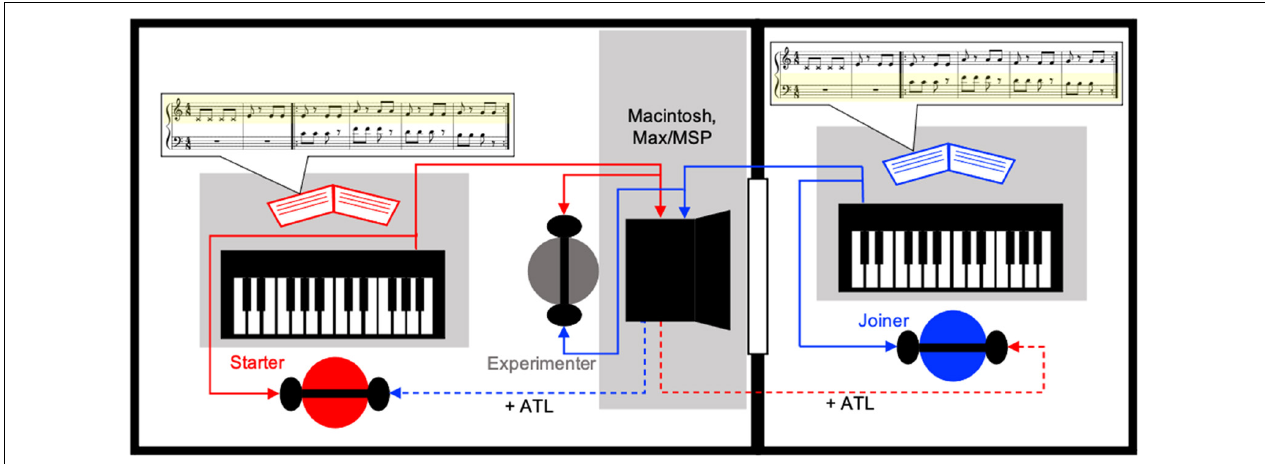
FIGURE 1 | The experimental set-up. The experimenter (center, gray circle) was able to see both pianists (red and blue circles) while they were located in separate rooms and could not see each other. The keyboards were controlled by the experimenter’s Macintosh computer with Max/MSP software such that the pianists always heard their own playing at the base latency inherent within the apparatus (solid red and blue lines) but heard their partner’s playing with an additional ATL of 10, 20, or 40 ms (dashed red and blue lines) during experimental trials. In this figure the left pianist (red) is performing the starter role (playing the associated yellow highlighted score part), with the right pianist (blue) performing the joiner role (playing the associated yellow highlighted score part). All pianists played both parts of all musical compositions; this role distribution occurred for half of the trials, while for the other half the roles were